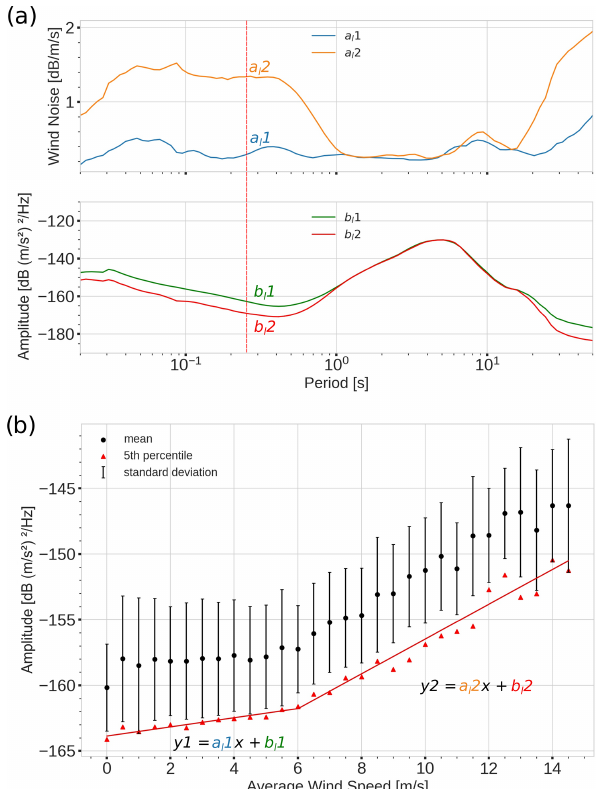
Figure 3. (a) Wind-induced noise model describing the parame- ters of two linear functions for every period of ELIS HHZ in 2017: the first panel represents the “ a ” parameter in the linear regression y = ax + b , and the second shows the “ b ” parameter. Those two dif- ferent linear relation parameters are until 6ms − 1 ( a l 1 /b l 1) and af- ter 6ms − 1 ( a l 2 /b l 2). (b) Behaviour of the 5th percentile (red) and mean (black) noise amplitude vs. the average wind speed (ms − 1 ) for the 0.26s period (red dotted line in Fig. 3a). There are two dif- ferent red linear functions: before 6ms − 1 ( y 1) and after 6ms − 1 ( y